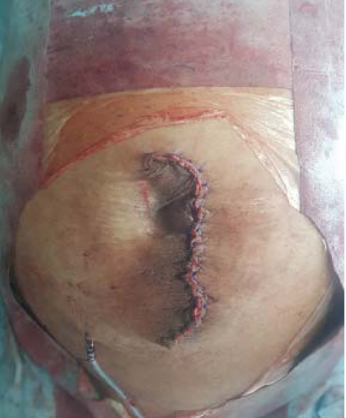
Figure 3. Following abdominal